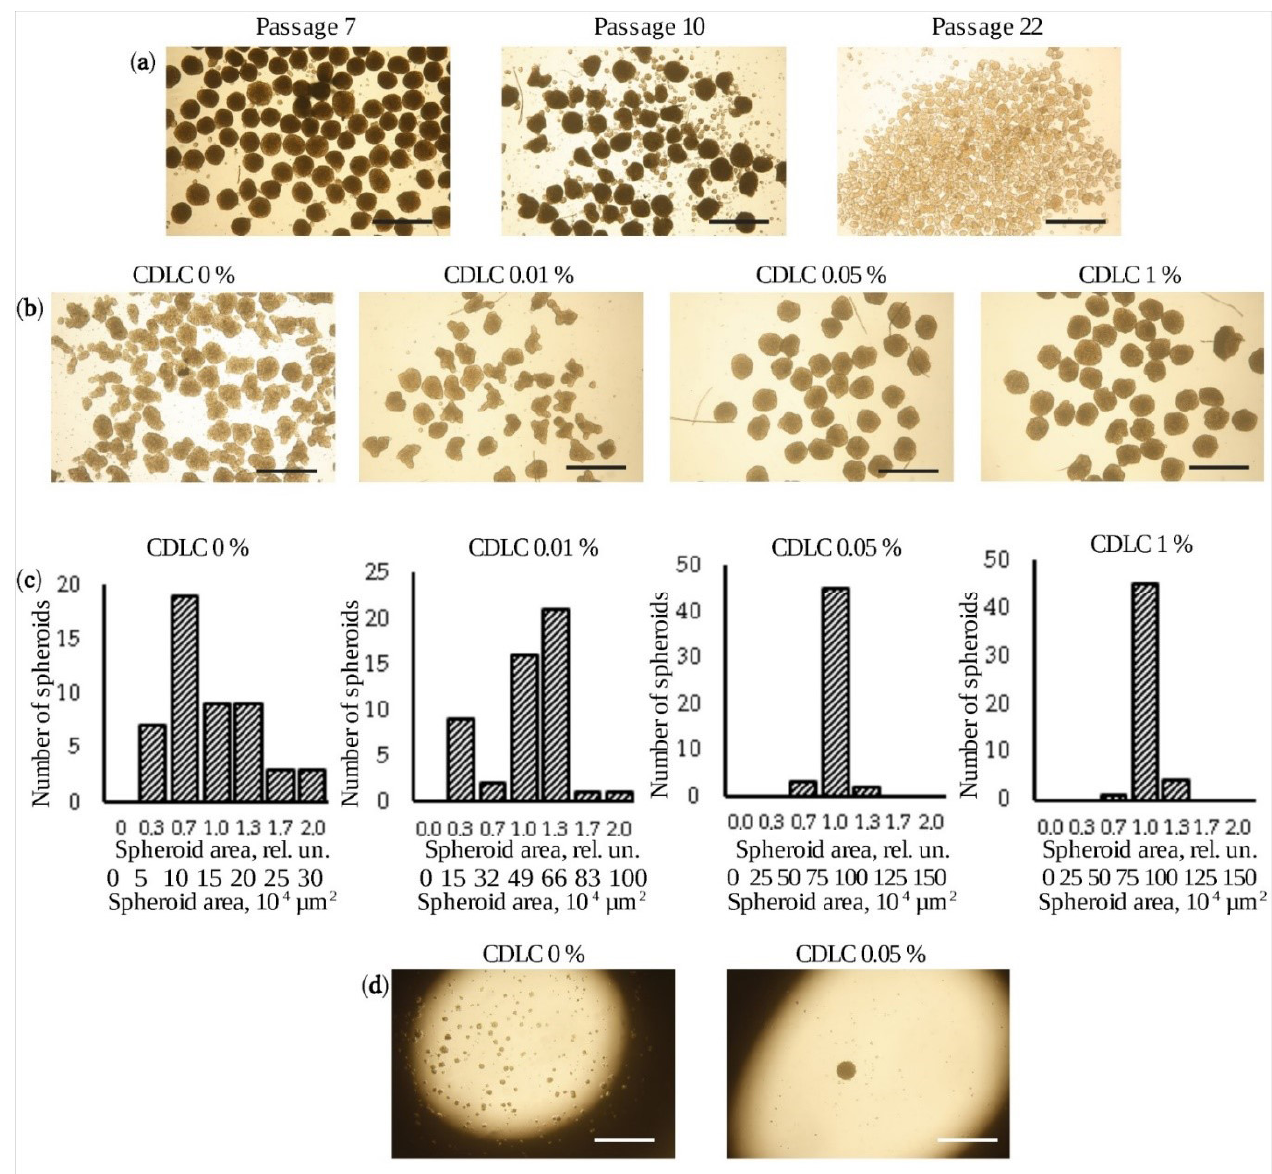
Figure 1. Generation of uniform-sized eMSC spheroids. ( a ) Aggregation of eMSCs into spheroids on different passages (scale bar, 600 μ m); ( b ) formation of uniform-sized eMSC spheroids in serum-containing medium supplemented with different concentrations of CDLC (scale bar, 600 μ m); ( c ) distribution of eMSC spheroid areas obtained from the analysis of the bright-field images of spheres generated in serum-containing medium supplemented with different concentrations of CDLC; the upper labels display the area normalized to the mean value in the sample, and the lower labels display the area in absolute numbers. ( d ) Phase-contrast microscopy showing the aggregation of eMSCs into a spheroid in a hanging drop in serum-containing medium with and without 0.05% CDLC after 48 h (scale bar, 600 μ m).